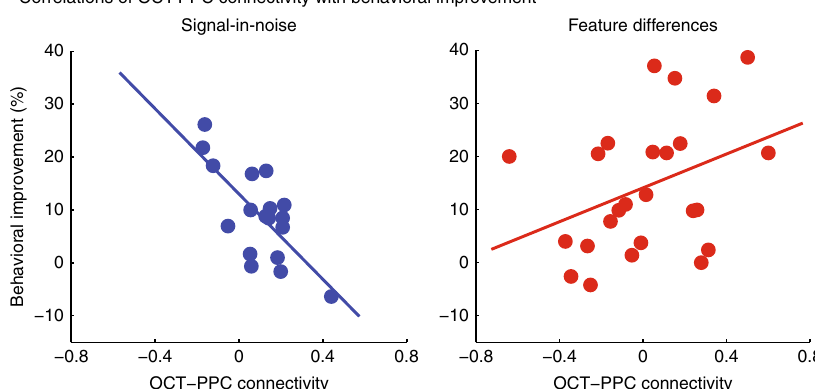
Fig. 5 Correlating occipito-temporal cortex (OCT)-posterior parietal cortex (PPC) functional connectivity with behavioral improvement. Skipped Pearson ’ s correlations showing a signi fi cant negative correlation of OCT-PPC connectivity with behavioral improvement for the signal-in-noise task ( n = 21, r = − 0.72, CI = [ − 0.90, − 0.29]), whereas a signi fi cant positive correlation for the feature differences task ( n = 25, r = 0.37, CI = [0.03, 0.69])